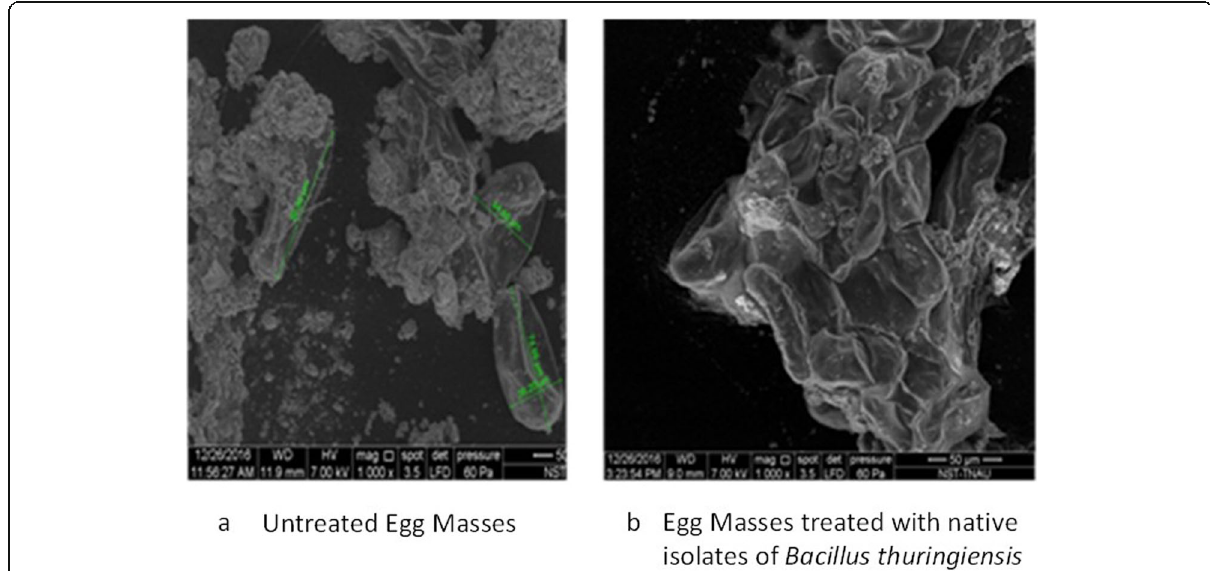
Fig. 6 SEM analysis of changes in egg masses treated with spore-crystal mixture of native isolates of Bacillus thuringiensis . a Untreated egg mass. b Egg mass treated with spore-crystal mixture. c Inhibition of hatching of egg masses by spore-crystal mixture